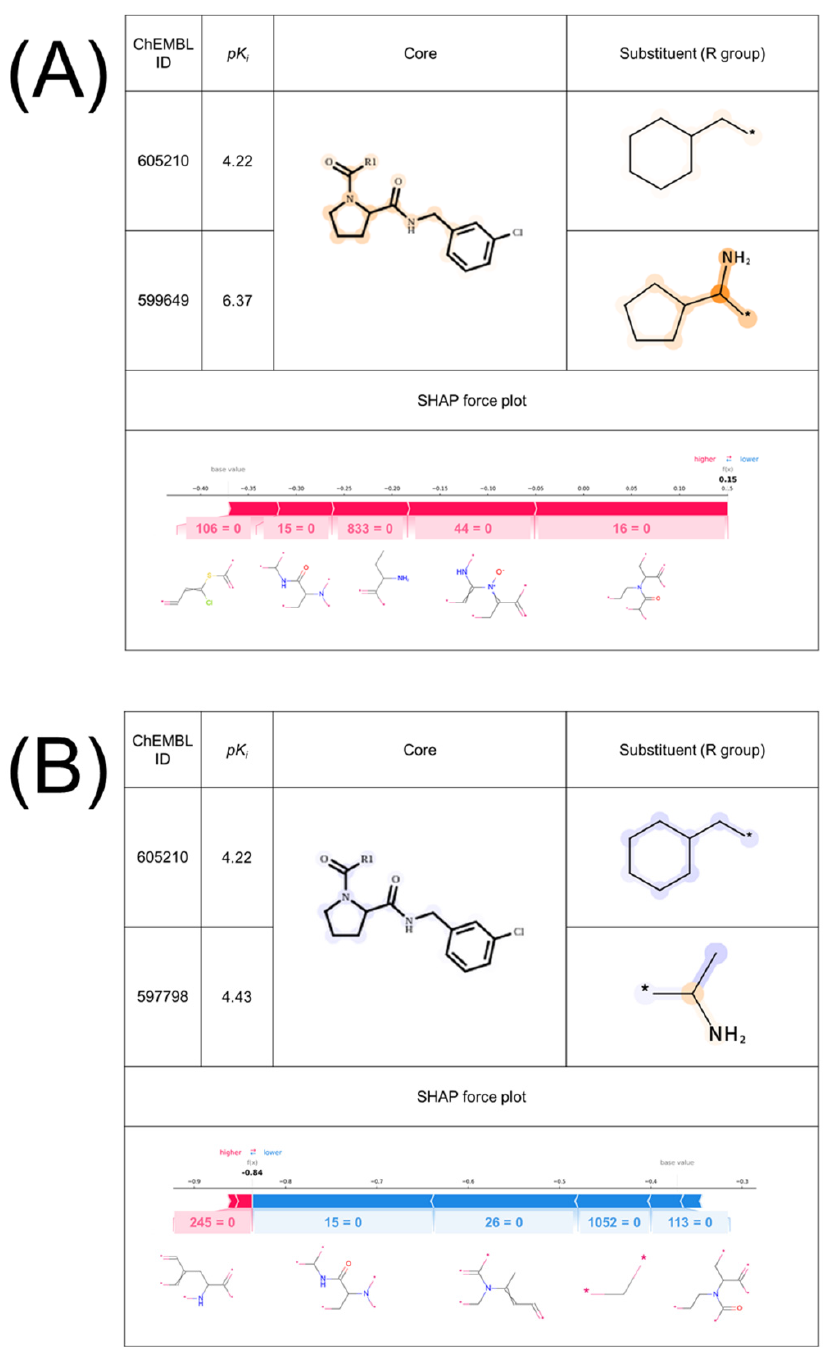
Figure 1. Comparison of the feature contribution mapping and SHAP for exemplary accurately predicted MMPs of thrombin. Exemplary ( A ) TP and ( B ) TN MMPs of thrombin with the feature contribution map and SHAP force plot for the MMPs are shown. MMPs are formed by ( A ) ChEMBL605210 and ChEMBL599649, and ( B ) ChEMBL605210 and ChEMBL597798. The core and substituent of the low potency compound in these MMPs were fixed to validate whether the model could capture the difference concerning the high potency compound. The orange color represents positive contribution and the blue color represents negative contribution. For the feature contribution mapping, higher contribution towards the predicted results is represented by a darker color. In the SHAP force plots, the baseline and output value (bold) are shown. The presence or absence of the substructures corresponding to the feature numbers are also shown as one or zero, respectively. The substructures corresponding to the feature numbers are shown below the plot.